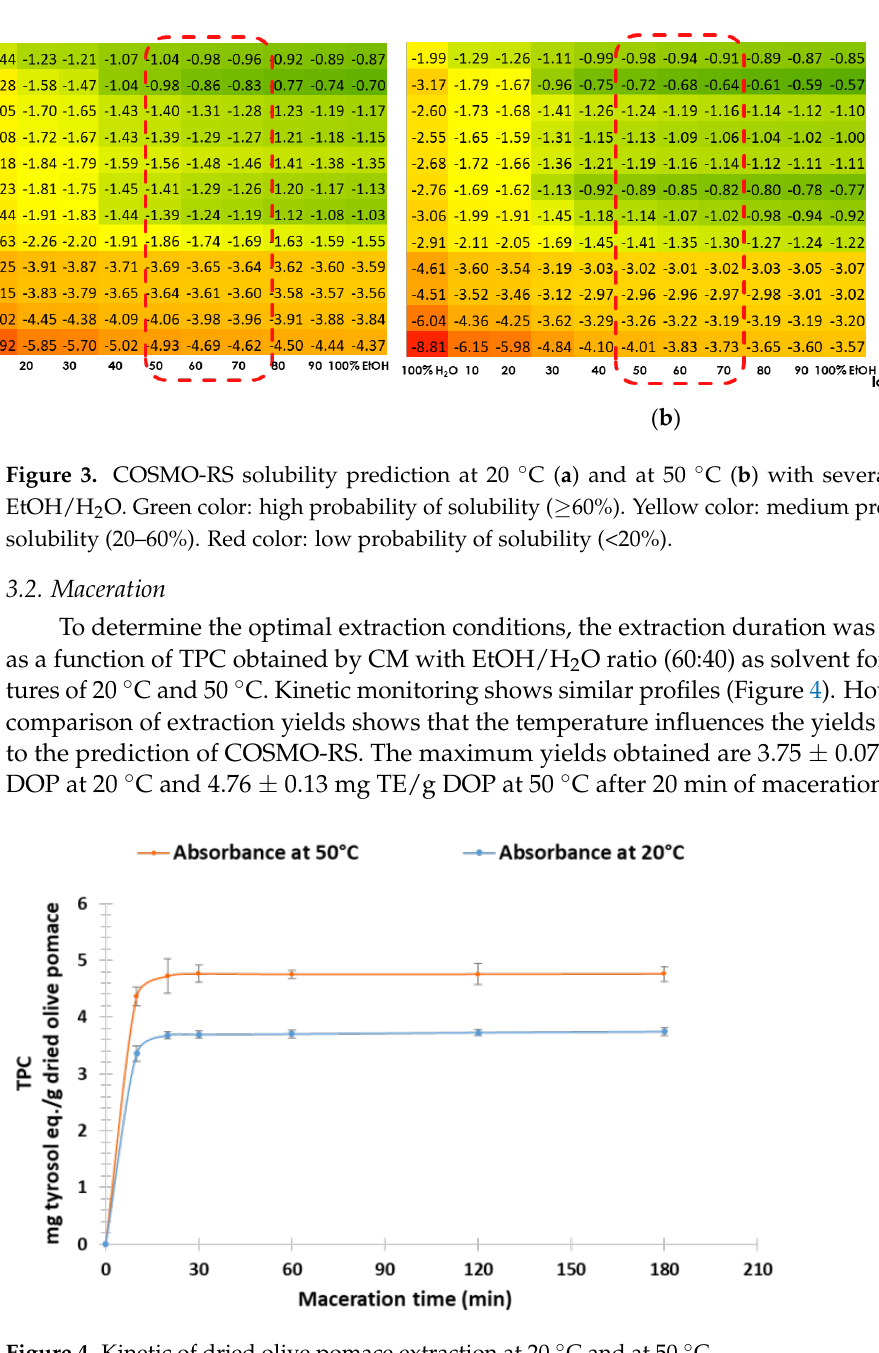
Figure 4. Kinetic of dried olive pomace extraction at 20 °C and at 50 °C. UPLC analyses corroborate the TPC results for the four quantified phenols: the highest extraction yields were obtained at 50 ◦ C. The highest concentration was obtained for 3- hydroxytyrosol with (39.0 ± 1.9) 10 − 2 and (57.6 ± 1.2) 10 − 2 mg HT/g DOP at 20 ◦ C and 50 ◦ C, respectively, followed by tyrosol with (23.4 ± 1.0) 10 − 2 and (27.9 ± 0.7) 10 − 2 mg TY/g DOP at 20 ◦ C and 50 ◦ C, respectively; then, p -coumaric acid with (20.6 ± 0.5) 10 − 2 and (23.5 ± 0.5) 10 − 2 mg p -CA/g DOP at 20 ◦ C and 50 ◦ C, respectively, and then caffeic acid with (16.3 ± 0.5) 10 − 2 mg CA/g DOP at both temperatures (Figure